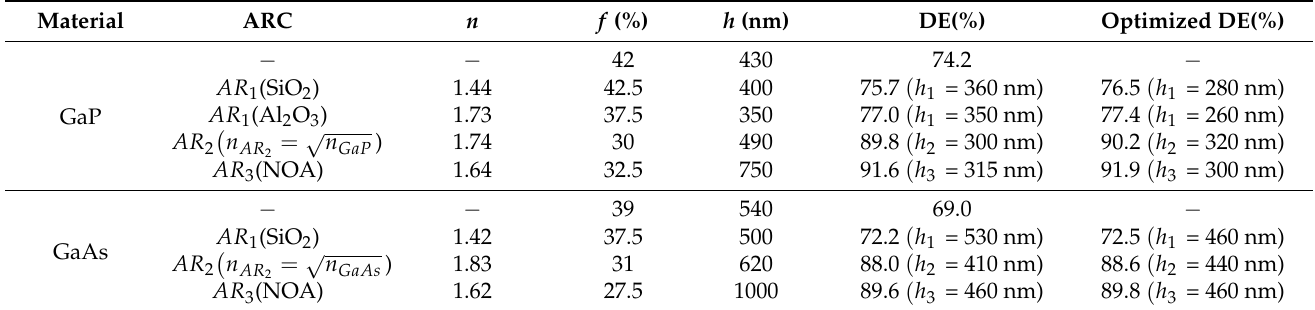
Table 1. Summary of calculated diffraction efficiencies and their corresponding parameters. Material